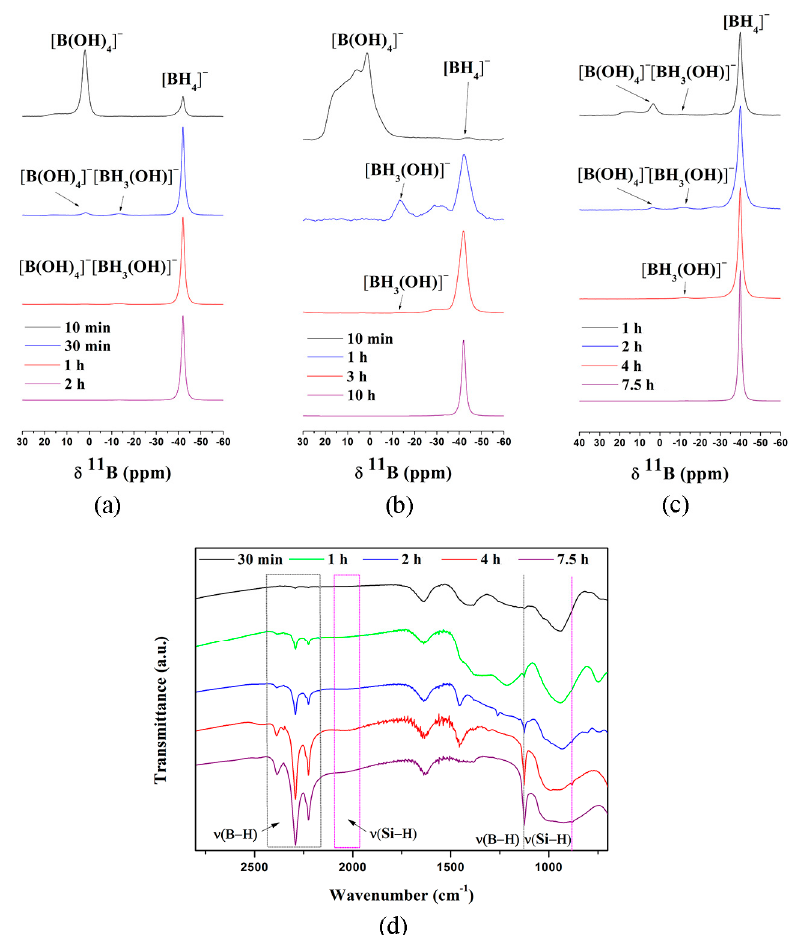
Figure 2. ( a ) Solid-state 11 B NMR spectra of products after ball milling MgH 2 and NaBO 2 ∙ 2H 2 O mixtures (in 5.0:1 mol ratio). ( b ) Solid-state 11 B NMR spectra of products after ball milling Mg and NaBO 2 ∙ 2H 2 O mixtures (in 5.0:1 mole ratio). ( c ) 11 B MAS NMR spectra of the products after ball milling Mg 2 Si and NaBO 2 · 2H 2 O mixtures (in 2:1 mol ratio). ( d ) FT-IR spectra of the products after ball milling Mg 2 Si and NaBO 2 ∙ 2H 2 O mixtures (in 2:1 mol ratio).